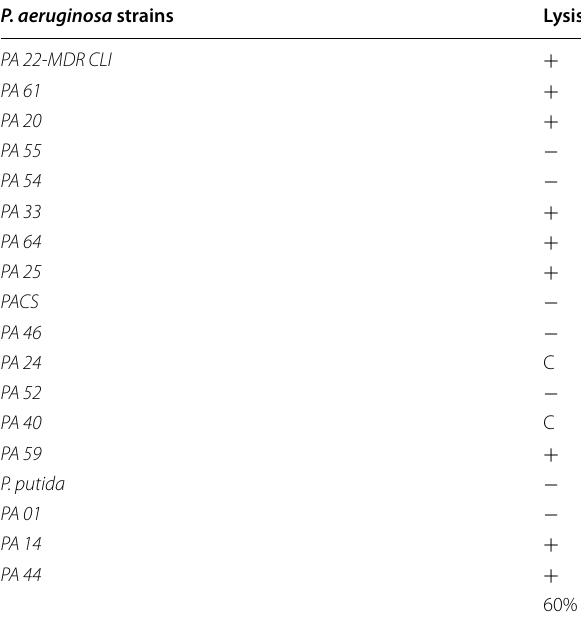
Table 2 Bacterial strains used in the study for ɸ ParuNE1 phage host